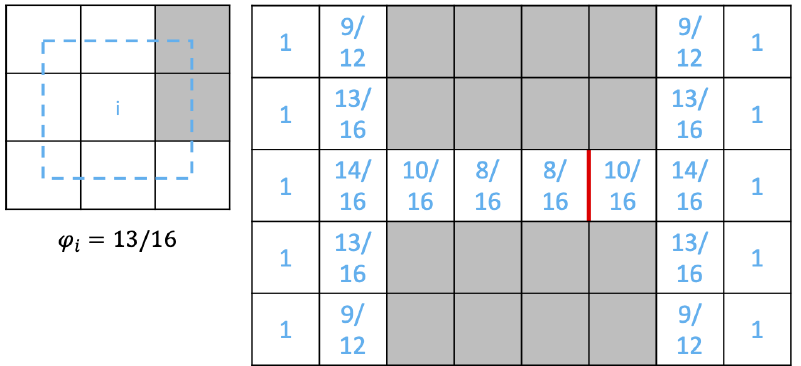
Figure 3. Safety factor based on anatomical disposition of tissue for a regular 2D grid. On the left, there is an example showing how to calculate SF for node i , as a ratio between healthy (white) and pathological (gray) tissue. On the right, there is an SCC with the SF calculated for each cell, showing a conduction block at the exit of the channel (red line), since transition from 8/16 to 10/16 cannot